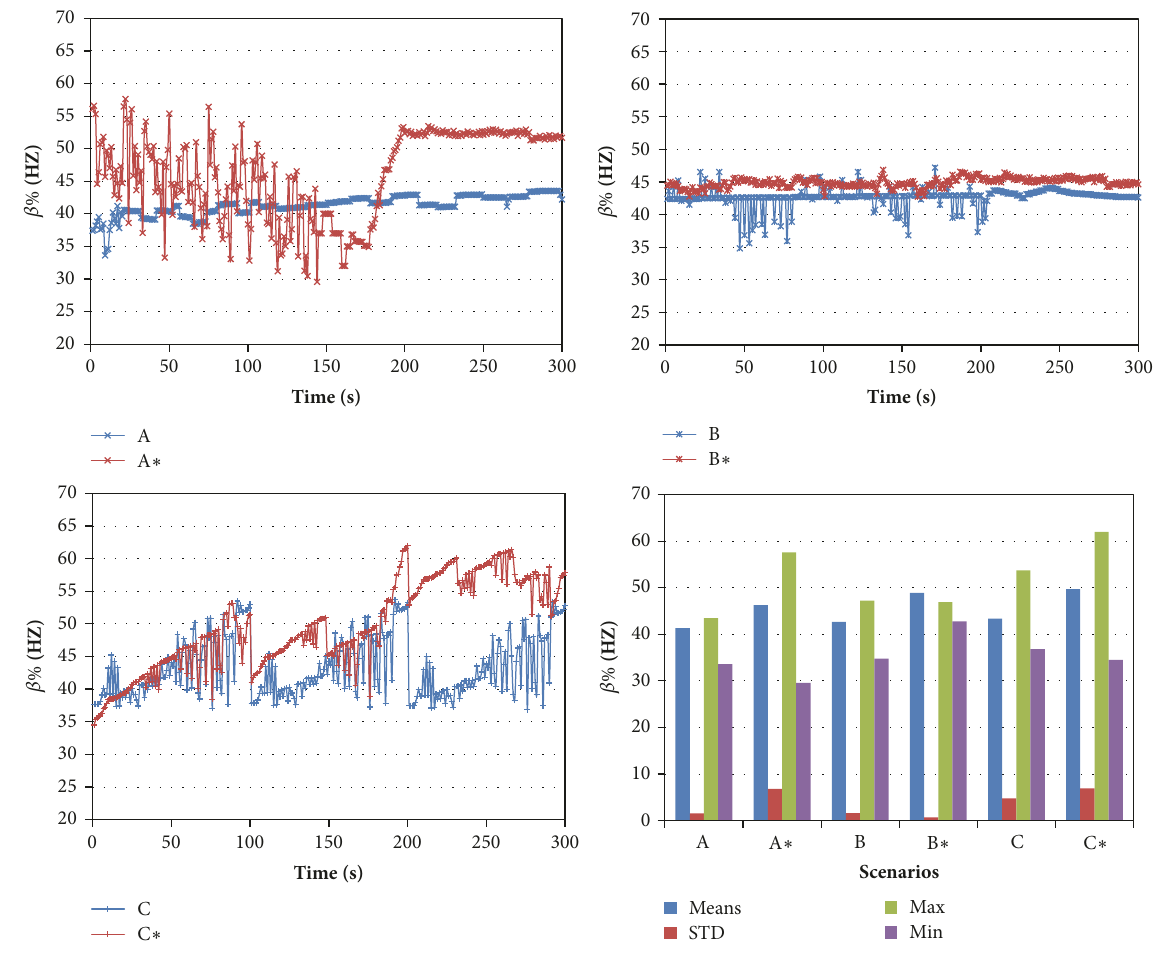
Figure 9: The value of 𝛽 % in different